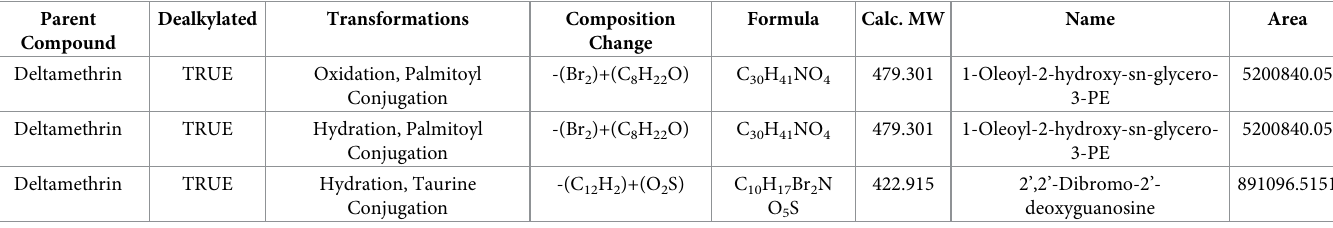
Dealkylated means whether dealkylation; Transformations means rection type; Composition Change means a change in the chemical formula; Formula means the molecular formula of the transformed compound; Calc. MW means the molecular weight of the transformed compound; Name means the full-spectrum identification of compound names. Area means peak area